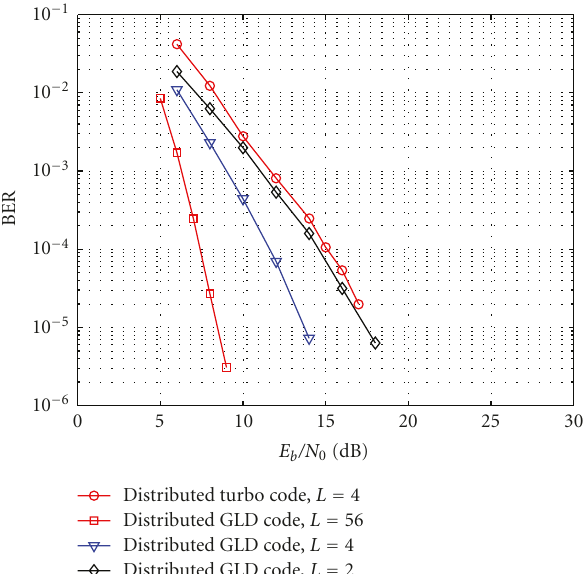
Figure 9: Performance comparison of distributed GLD codes ( R = 7 / 45) and distributed turbo codes ( R = 1 / 6).